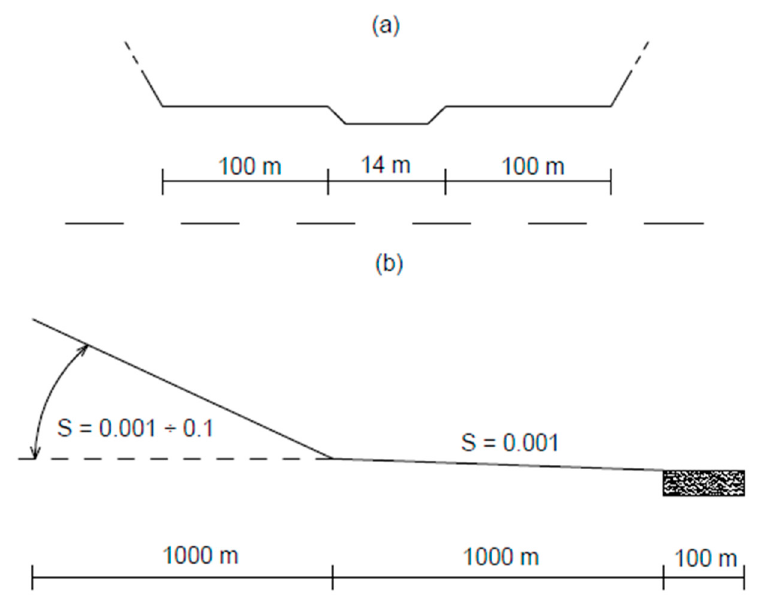
Figure 1. Schematic illustration of the idealised valley, including: ( a ) the cross-section and ( b ) the longitudinal section.